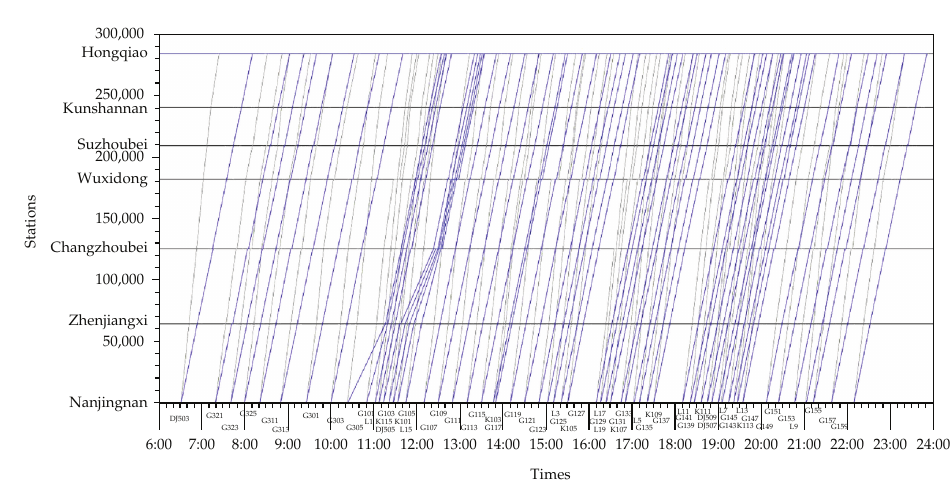
Figure 8: Timetable of speed restriction in all sections and two trains